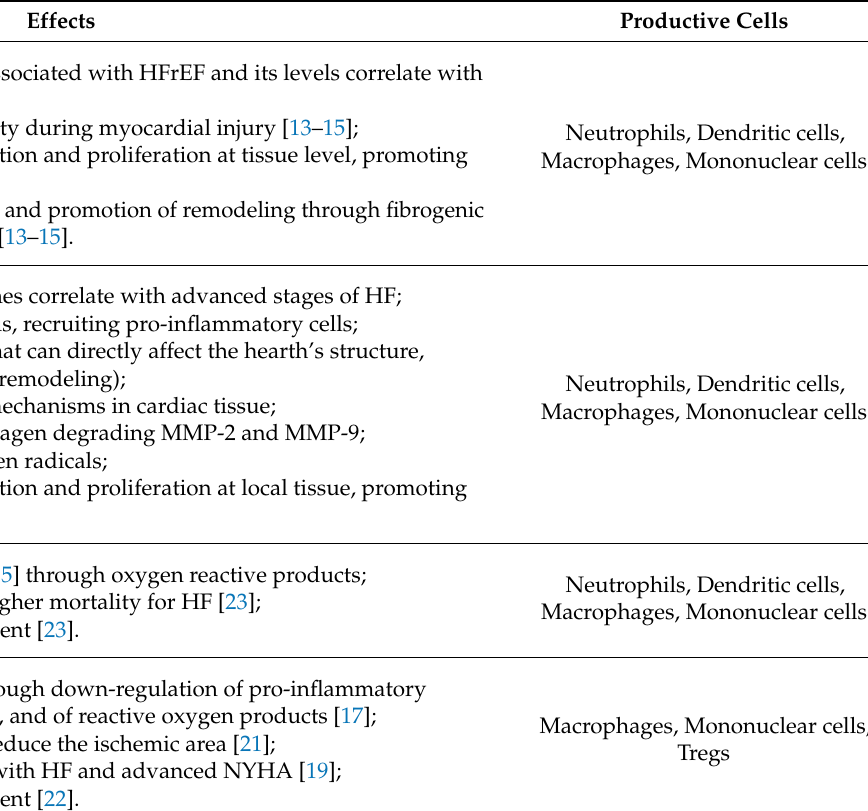
Table 1. Interleukins and